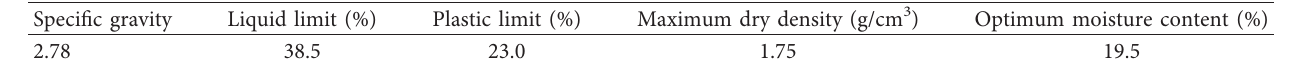
Figure 10: The calculation example of displacement field: (a) initial image; (b) horizontal tensile displacement is 0.005mm; (c) horizontal tensile displacement is 0.01mm; (d) gradient cloud map of the displacement field in (b); (e) gradient cloud map of the displacement field in (c); (f) tensile failure form. Table 1: The basic physical index of test